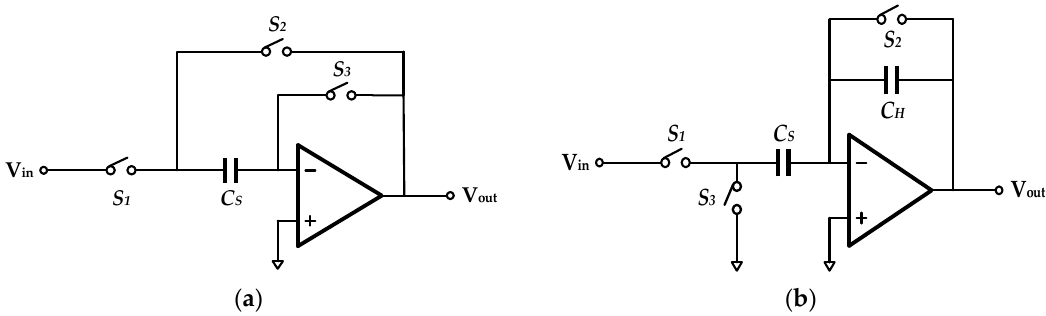
Figure 7. ( a ) Flip-around sampling holder, ( b ) charge-redistribution sampling holder.